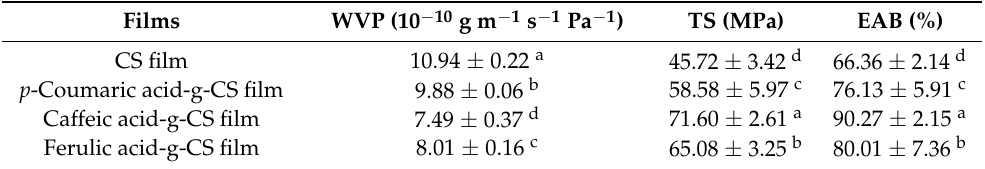
Table 2. Water vapor permeability (WVP), tensile strength (TS) and elongation at break (EAB) of chitosan (CS), p -coumaric acid-g-CS, caffeic acid-g-CS and ferulic acid-g-CS films.